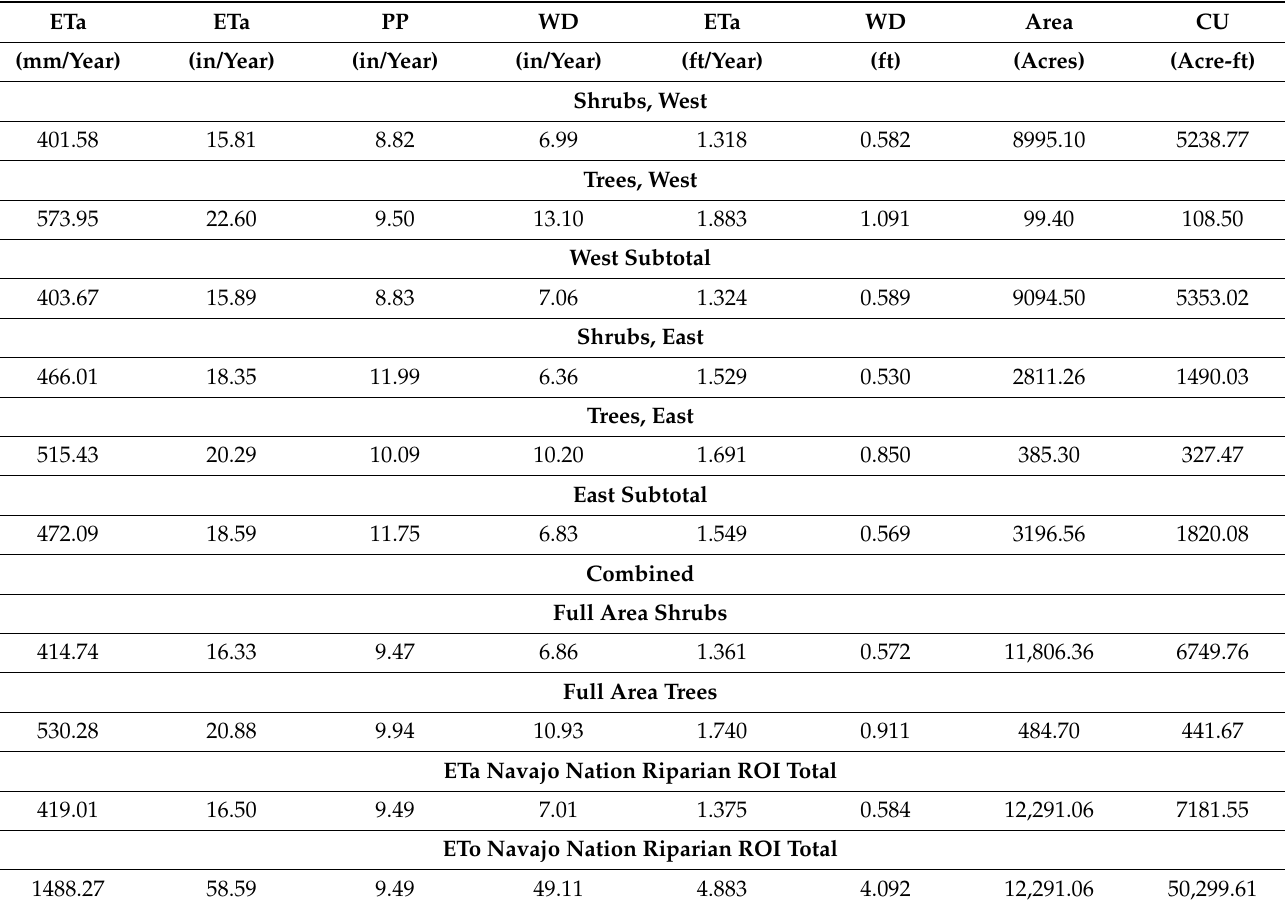
Table 8. Final water metric results for the riparian ROI showing the vector-based method of ‘digitized polygons’ of the mean data from 2014 to 2020 using gridded Daymet weather data (1 km) and Landsat (30-m) to derive ETa (mm, in, ft), PP (in), WD (in, ft) and ETo (mm, in, ft) (last row); the CU (acre-ft, last column) is calculated by ground area for shrubs, trees, and total riparian